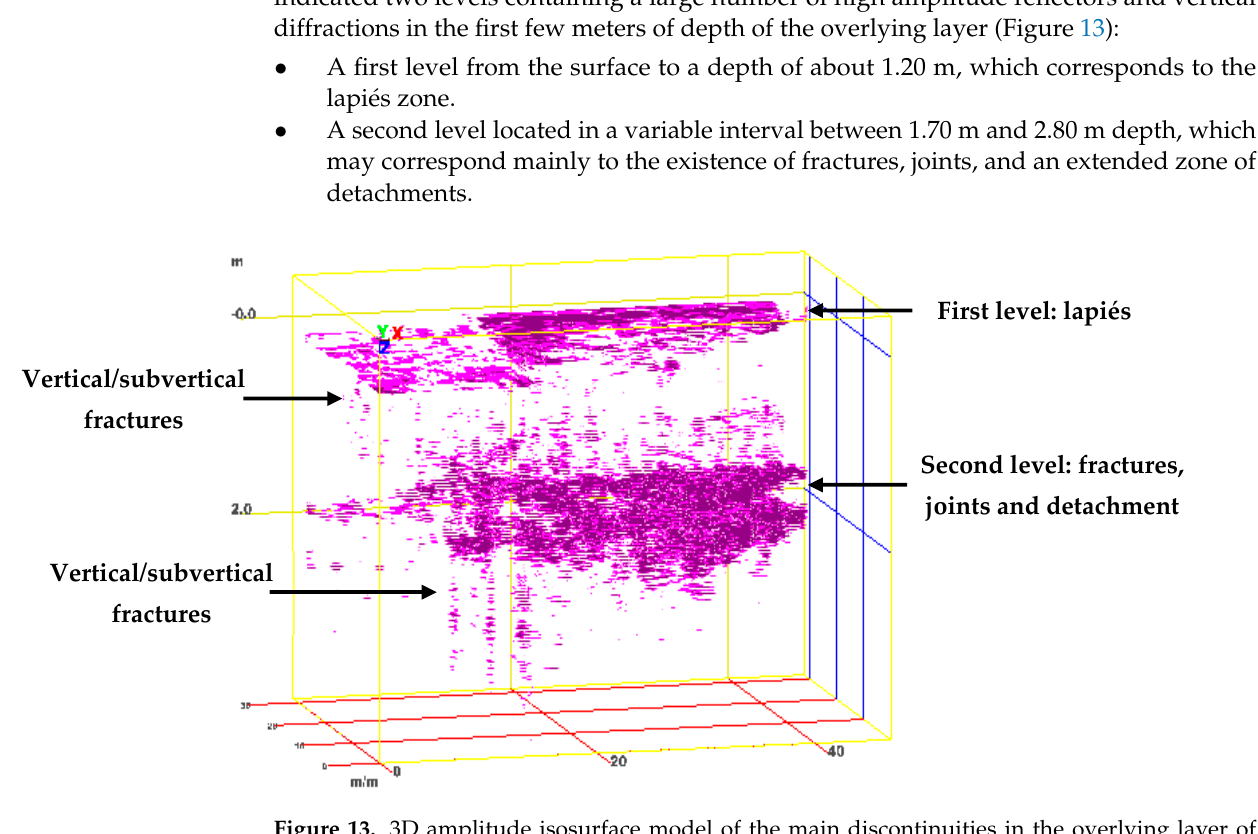
Figure 13. 3D amplitude isosurface model of the main discontinuities in the overlying layer of the Polychrome Hall with the 400 MHz antenna, showing the two levels of discontinuities (lapiés zone—fractures, joints, and detachment zone) and the vertical fractures.